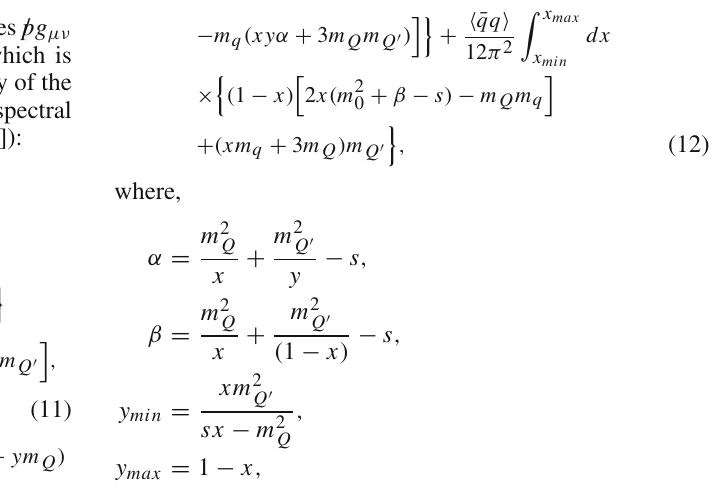
Fig. 1 The dependency of the excited states 2 S , 1 P masses of the doubly-heavy spin-(3/2) (cid:2) ∗ cc , and (cid:2) ∗ values of the continuum threshold s 0